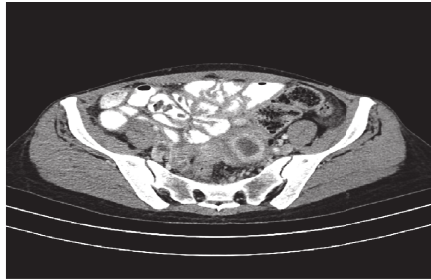
Figure4:CTofpelvisdemonstratingreductionofadnexalmassand decompressed bowel loops at 1 year of